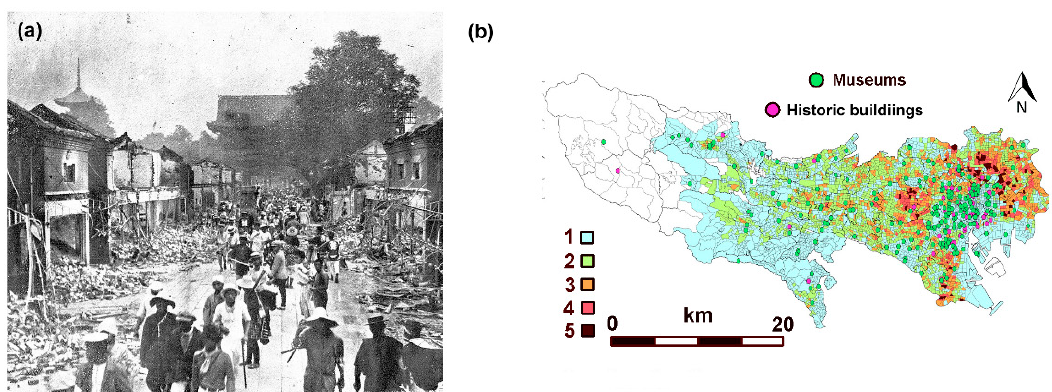
Figure 7. ( a ) Photograph of devastation in the area around Sens ō -ji Temple, Asakusa after the Great Kant ō earthquake of 1923, with smoke from fires in the background. Source: Public Domain File: Theosakamainichi-earthquakepictorialedition-1923-page9-crop.jpg [56] ( b ) The map of combined earthquake risks for Tokyo. Source: TMG 2018 and National Land Numerical Information (https://nlftp.mlit.go.jp/ [2] ).